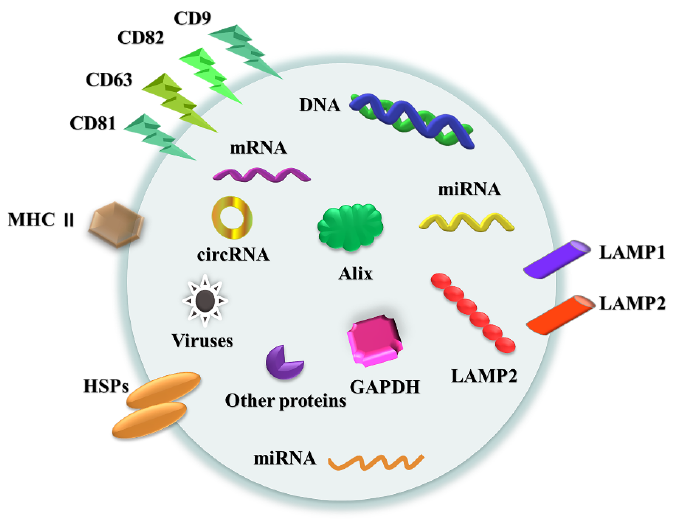
Figure 2. Exosomes contain proteins, nucleic acids, and other substances. Their proteins include heat shock proteins (HSP70, HSP90), four-transmembrane protein superfamily proteins (CD9, CD63, CD81, CD82), ESCRT complex-related proteins (Tsg101, Alix), glyceraldehyde-3-phosphate dehydrogenase (GAPDH), lysosomal associated membrane protein (LAMP1, LAMP2) and other proteins. Their nucleic acids include mRNA, miRNA, circRNA, DNA and so on. The other substances include specific components, which are closely related to their progenitor cells, that is, cell-specific molecules, such as MHC-II derived from antigen-presenting